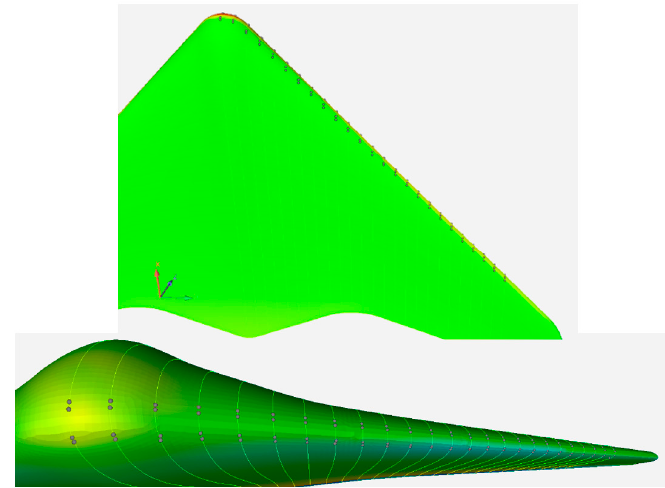
Figure 1. The illustration of the candidate locations. Table 1. The comparisons of the prediction error.